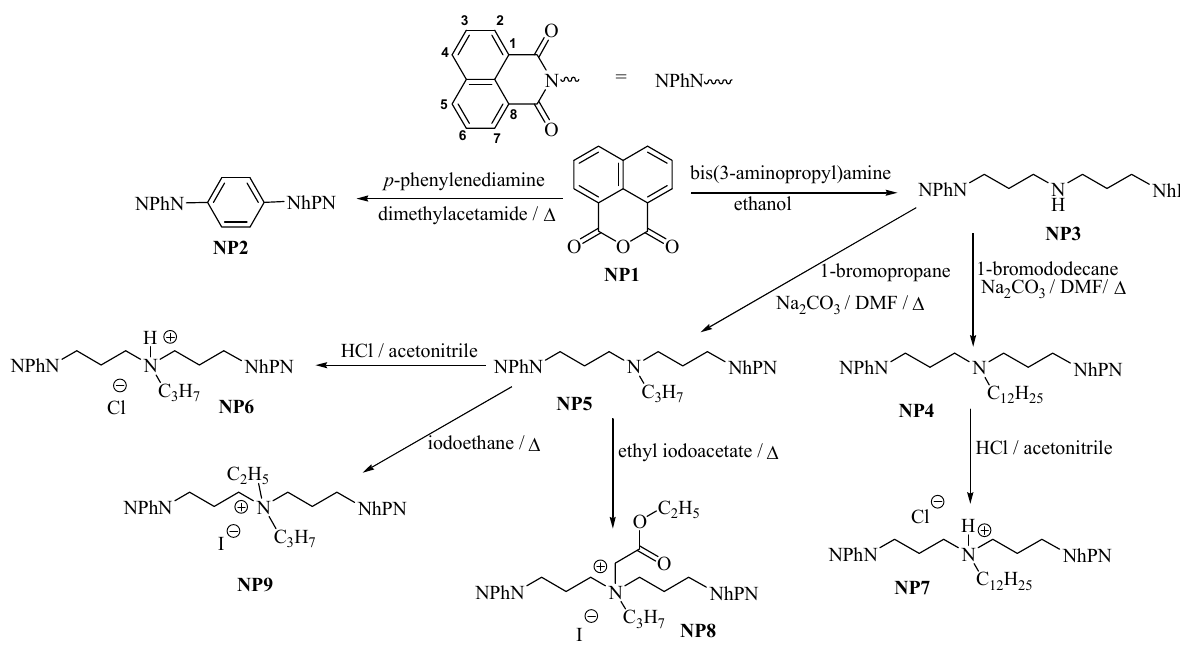
Scheme 1. Synthesis of bis-naphthalimide